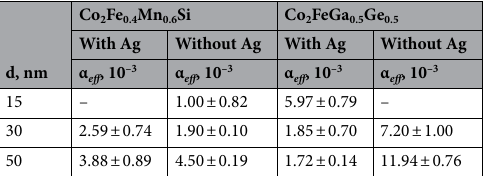
Table 2. The effective magnetic damping parameter α eff values for the studied CFMS and CFGG